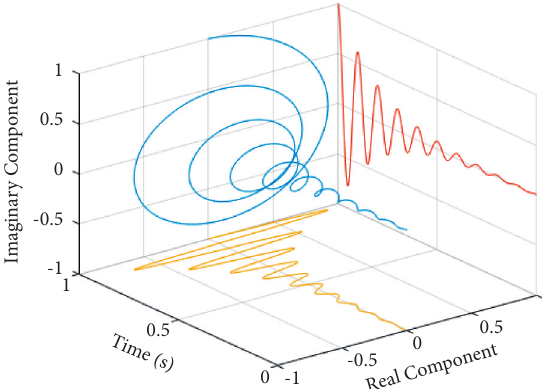
Figure 2: Laplace wavelet